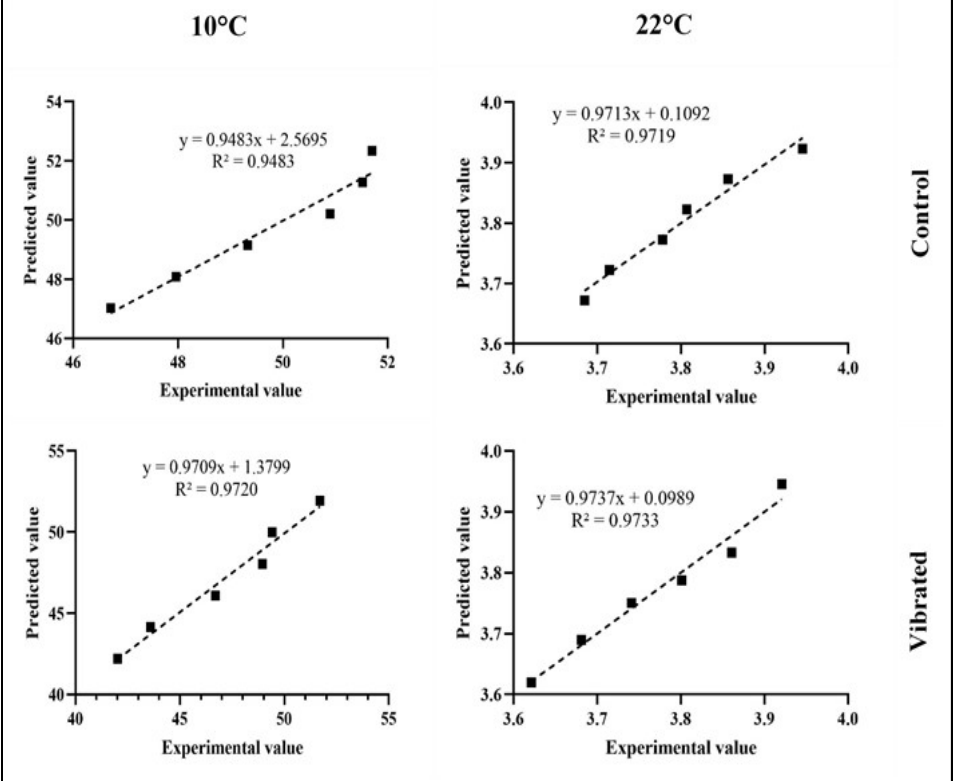
Figure 4. Predicted and experimental results of L* change kinetic of vibrated and non-vibrated (con- trol) tomatoes stored at10 °C and 22 °C. (control) tomatoes stored at10 ◦ C and 22 ◦